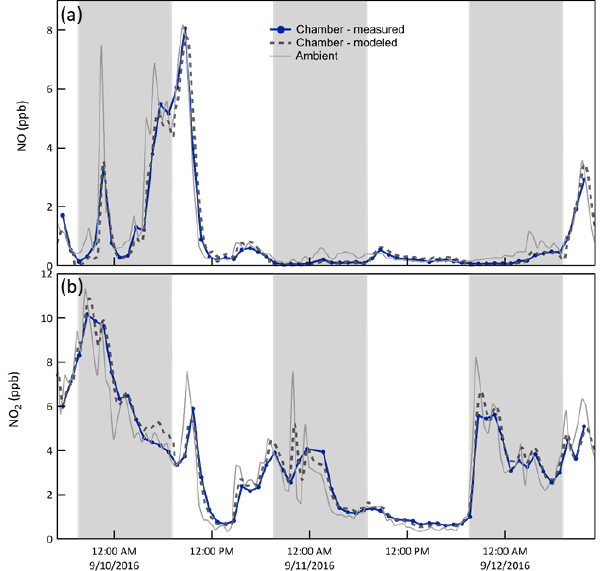
Figure 7. Time series of NO and NO 2 mixing ratios (i) measured in chamber B (solid blue), (ii) expected in the chamber as calcu- lated from the CSTR 0D model (dashed), and (iii) measured outside (solid gray). Smoothing of the spikes in the ambient time series re- sults from treatment of the chamber as a CSTR. The shaded bands represent nighttime.